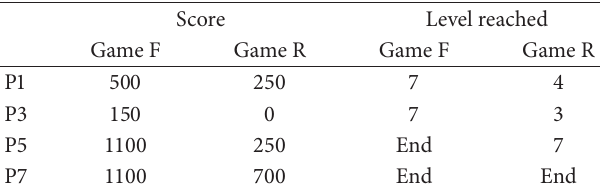
Table 2: Player scoring and game completion data for Group 1.